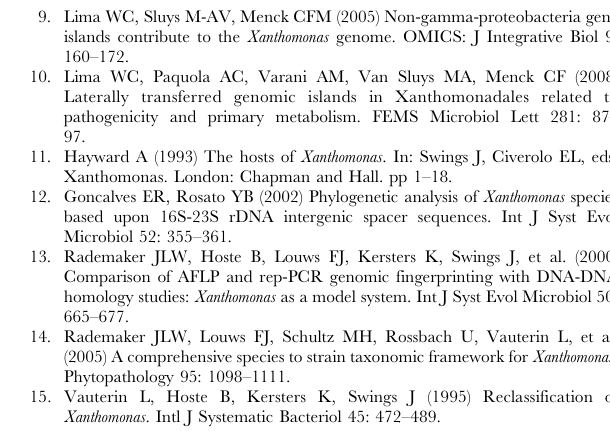
Table S2 Coordinates (bp) of the gene clusters examined in the eight Xanthomonas